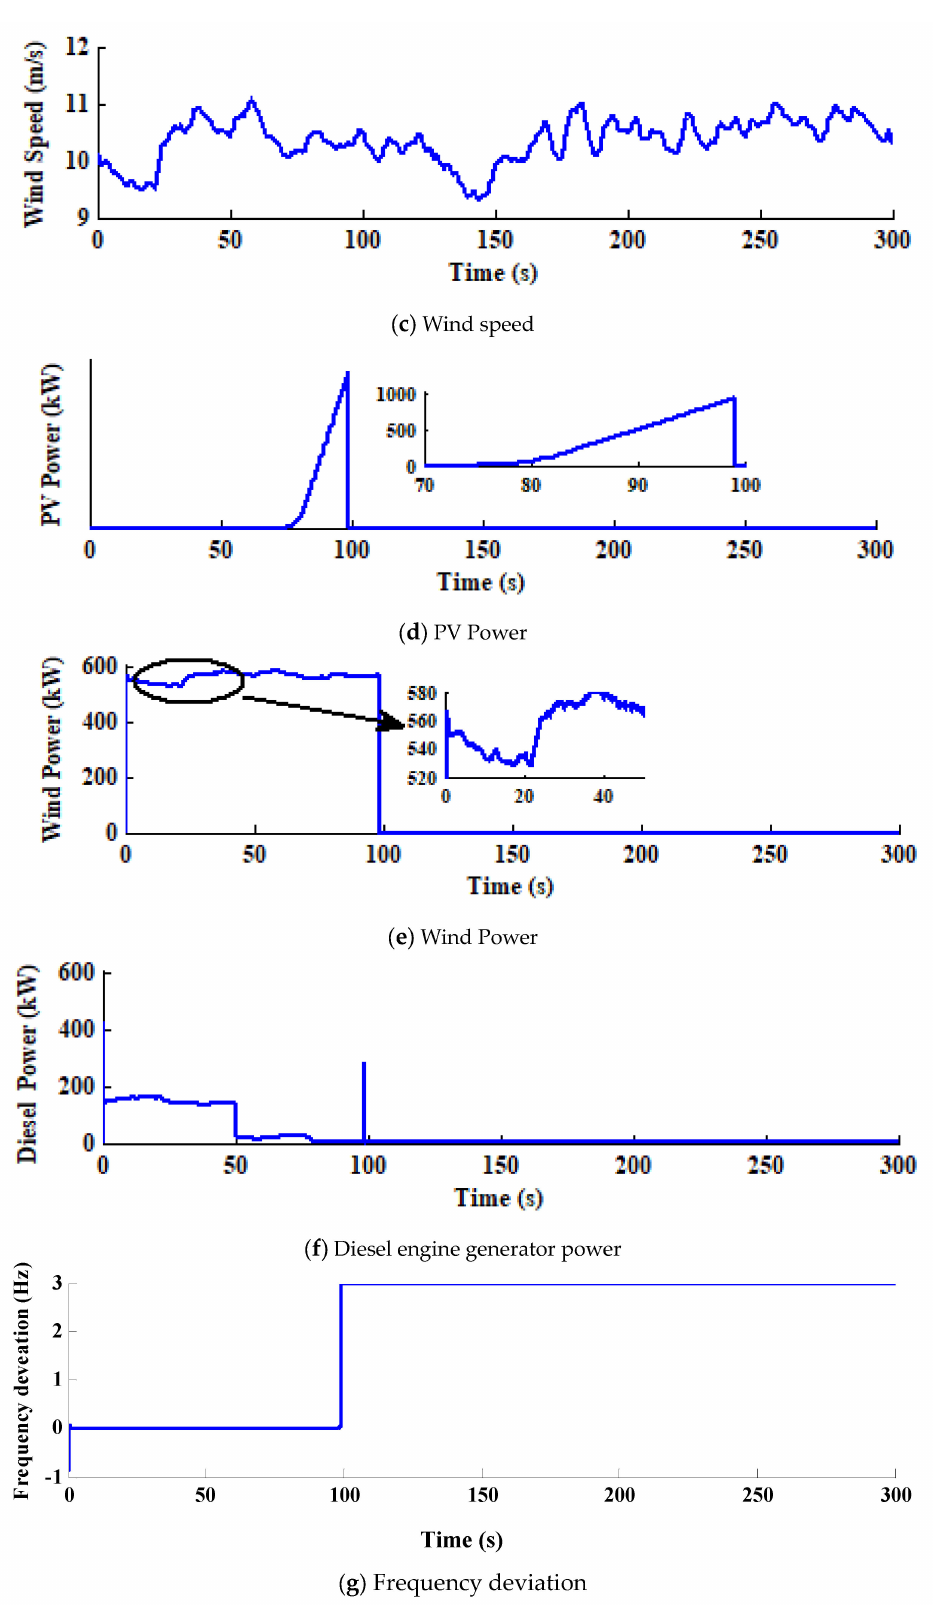
Figure 9. The simulation results for scenario 1 under high penetration level of